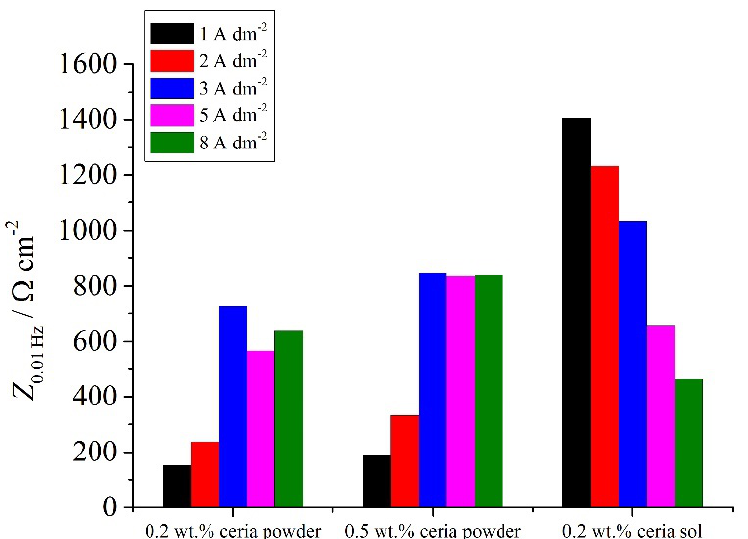
Figure 15. The low-frequency impedance modulus (at 0.01 Hz) for different samples deposited under ultrasound.